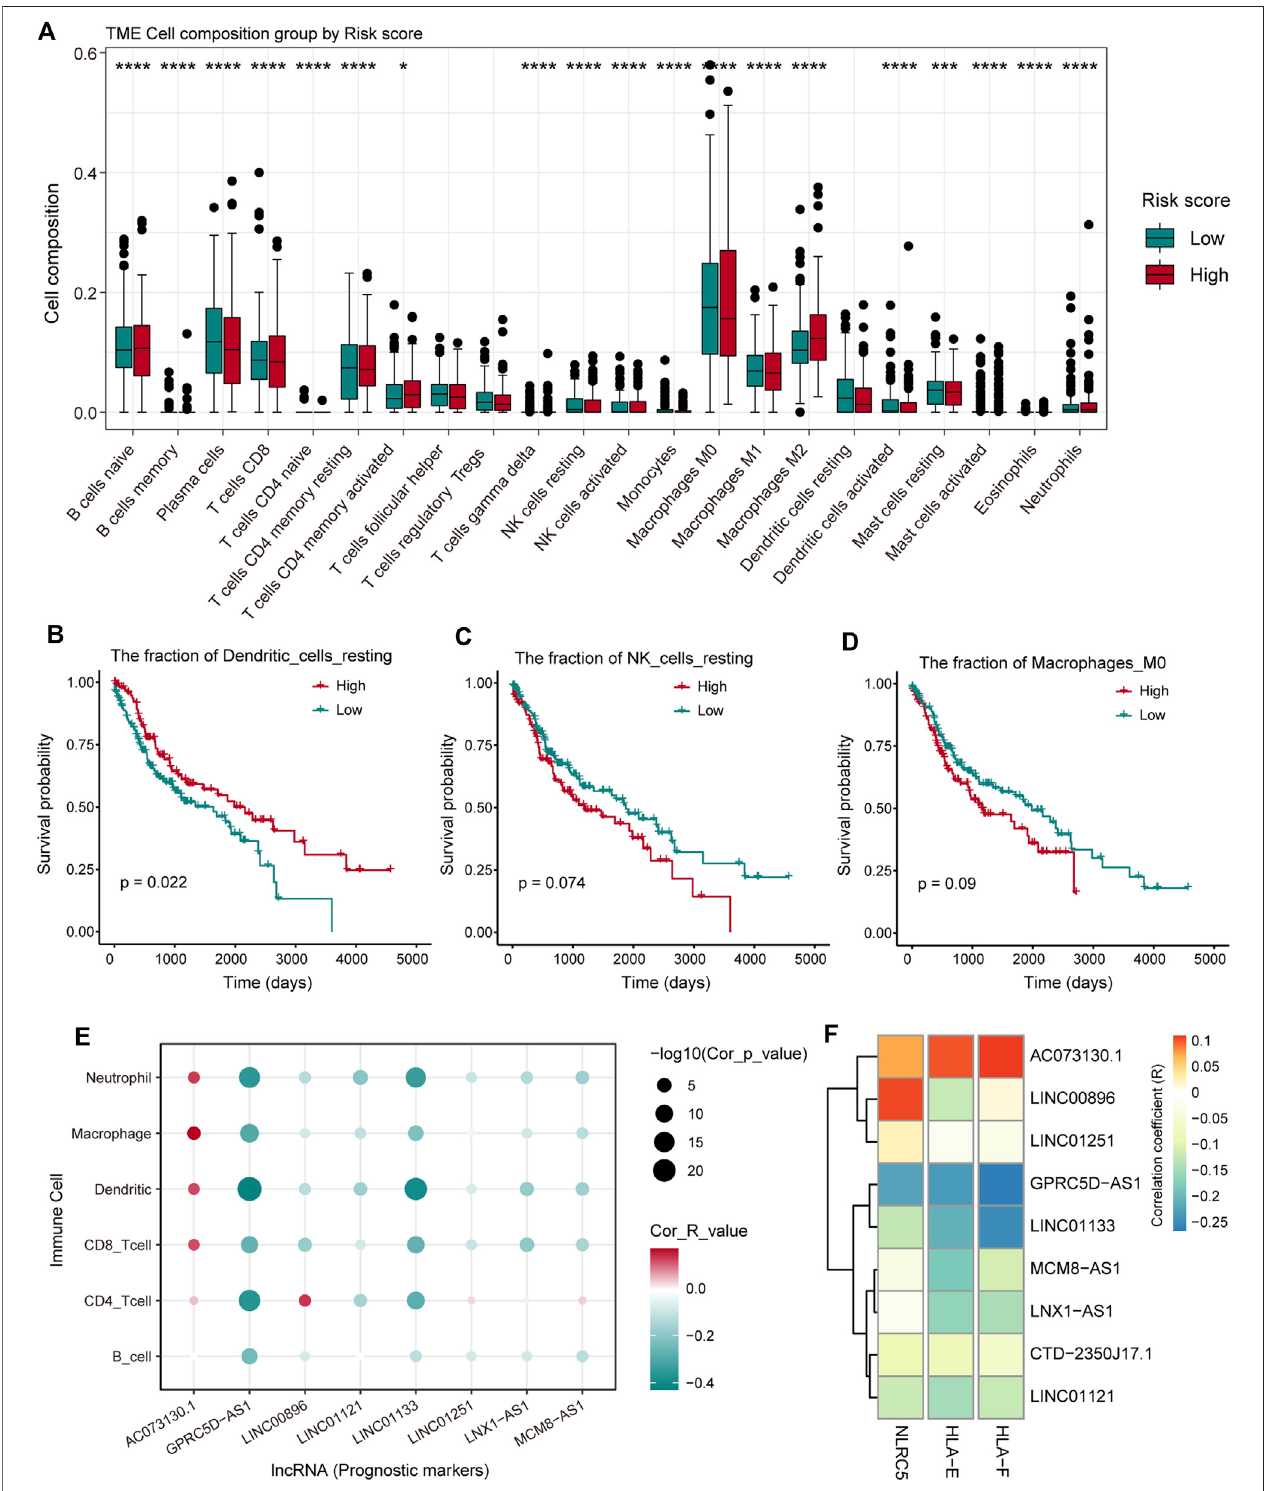
FIGURE 5 | The analysis of the relationship between pr-lncRNAs and tumor immune activity. (A) The in fi ltration abundance of 22 types of leukocytes between the high- and low-riskgroupsisdisplayed byaboxplot. The p -valueswerecalculatedbytheMann – Whitney U test. (B – D) Kaplan – Meiercurve ofthetwogroups(high-/low- in fi ltration abundance) for resting dendritic cells, resting natural killer (NK) cells, and macrophage M0. Log-rank test is used to calculate statistical signi fi cance. (E) The bubble chart shows the correlation between the in fi ltration abundance of the six immune cells and the expression of pr-lncRNA. (F) The relationship between the expression ofgenesencoding majorhistocompatibility complexI(MHC I) molecules and thatofpr-lncRNAs isdisplayed byaheatmap. Thestronger thecorrelation,the darker the color.